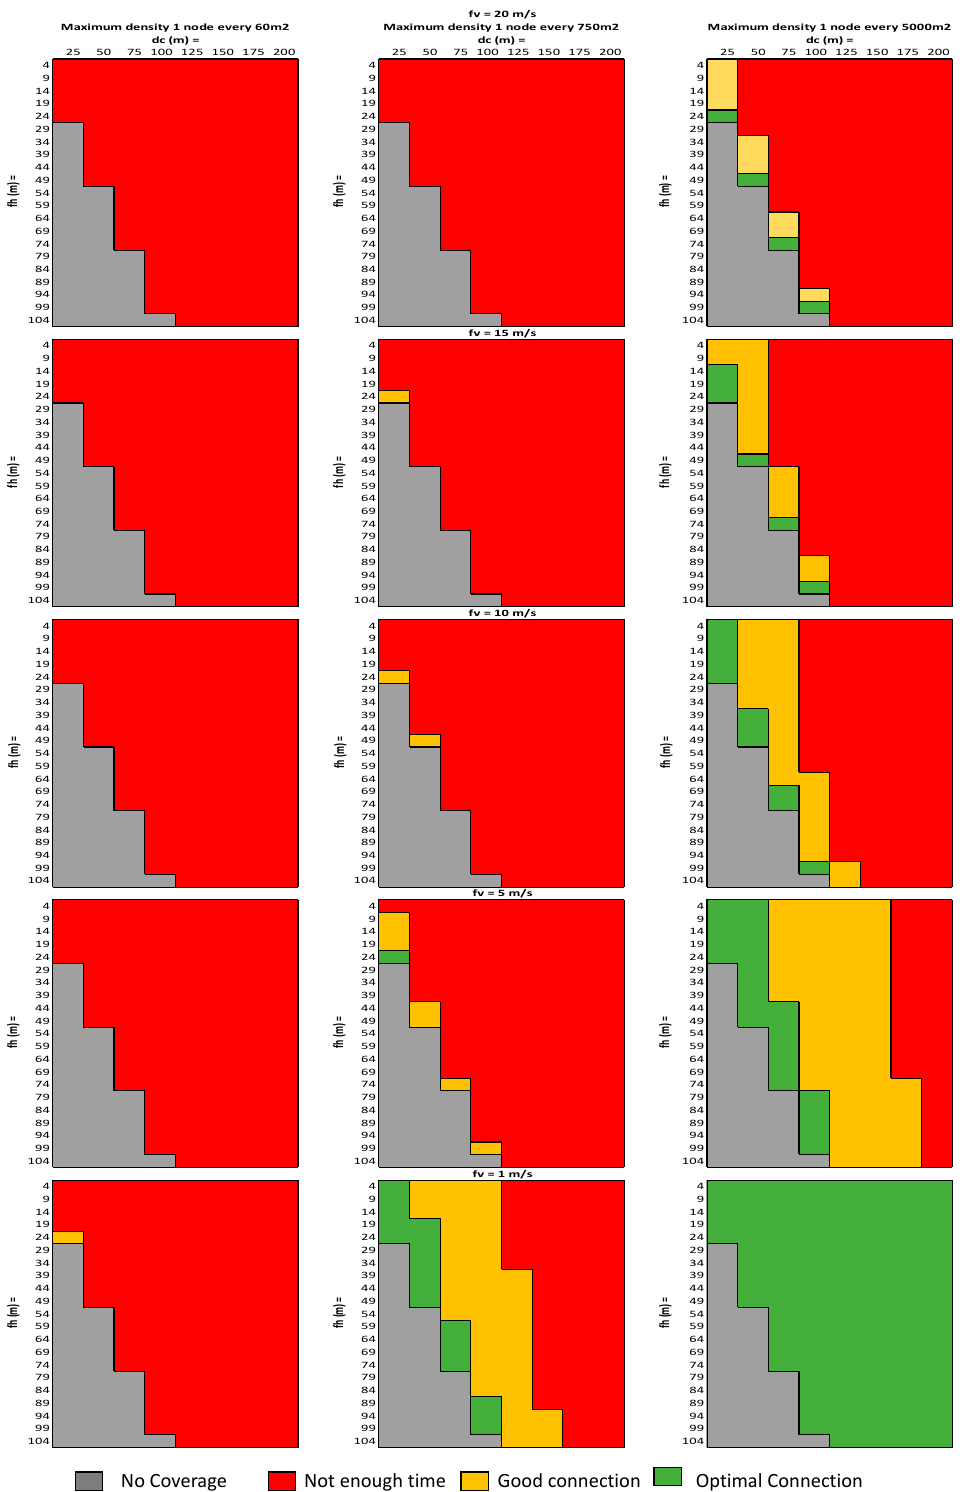
Figure 13. Summary of communication in different scenarios: gray is no coverage (NC), red is not enough time in coverage.